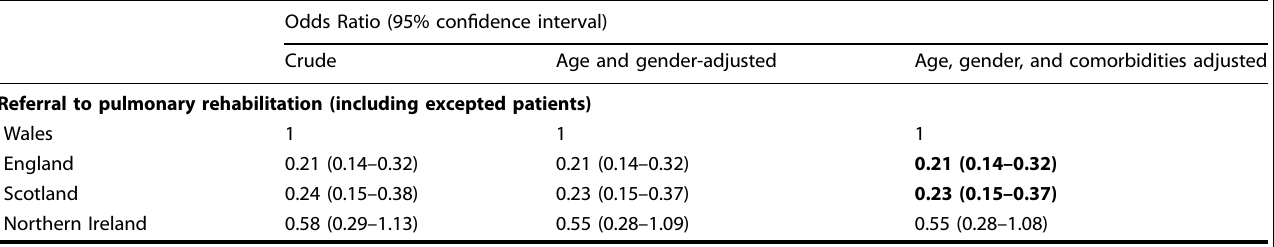
Table 2. Odds ratios and 95% con fi dence intervals for receipt of a referral to pulmonary rehabilitation, including patients that were exempted from referral to pulmonary rehabilitation, for each UK country relative to Wales in crude and adjusted